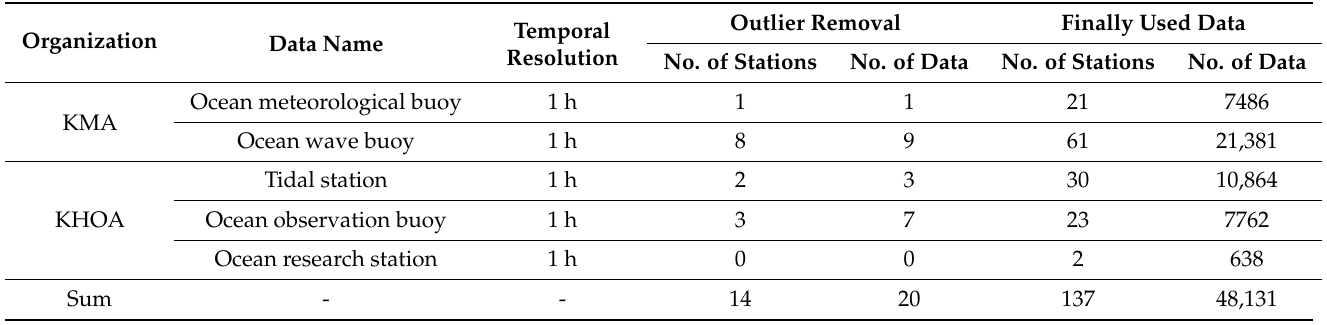
Figure 3. Flow chart of the spatial gap-filling method proposed in this study. Table 4. Overview of in situ SST observations. A total of 20 cases from 14 stations were removed as outliers, and 48,131 observations from 137 stations were finally